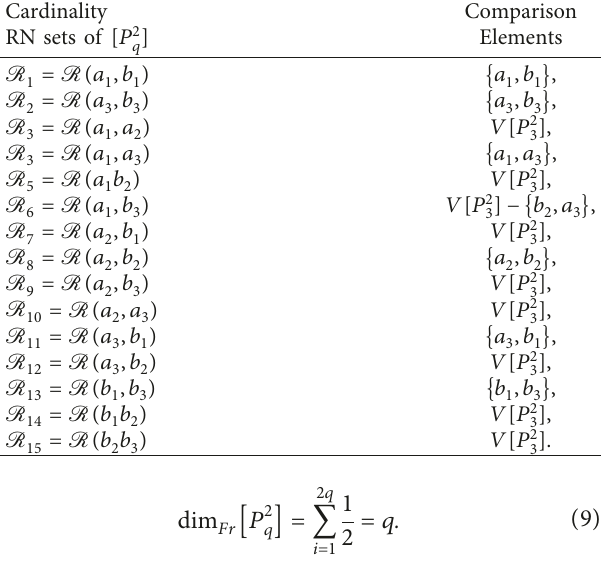
Table 6: Cardinality of each RN set. Cardinality